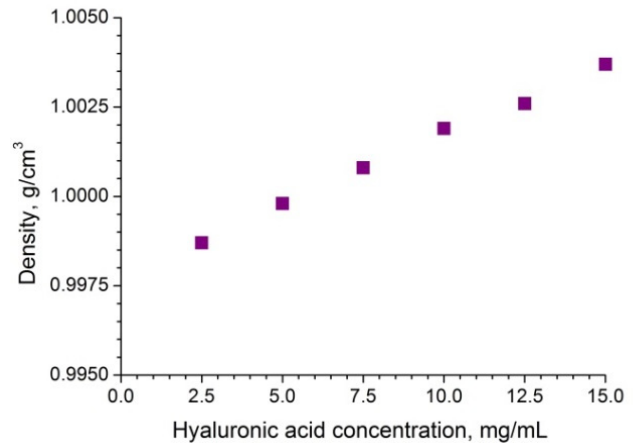
Figure 4. Dependence of the solution density from hyaluronic acid concentration at 25.0 ± 1.0 °C.